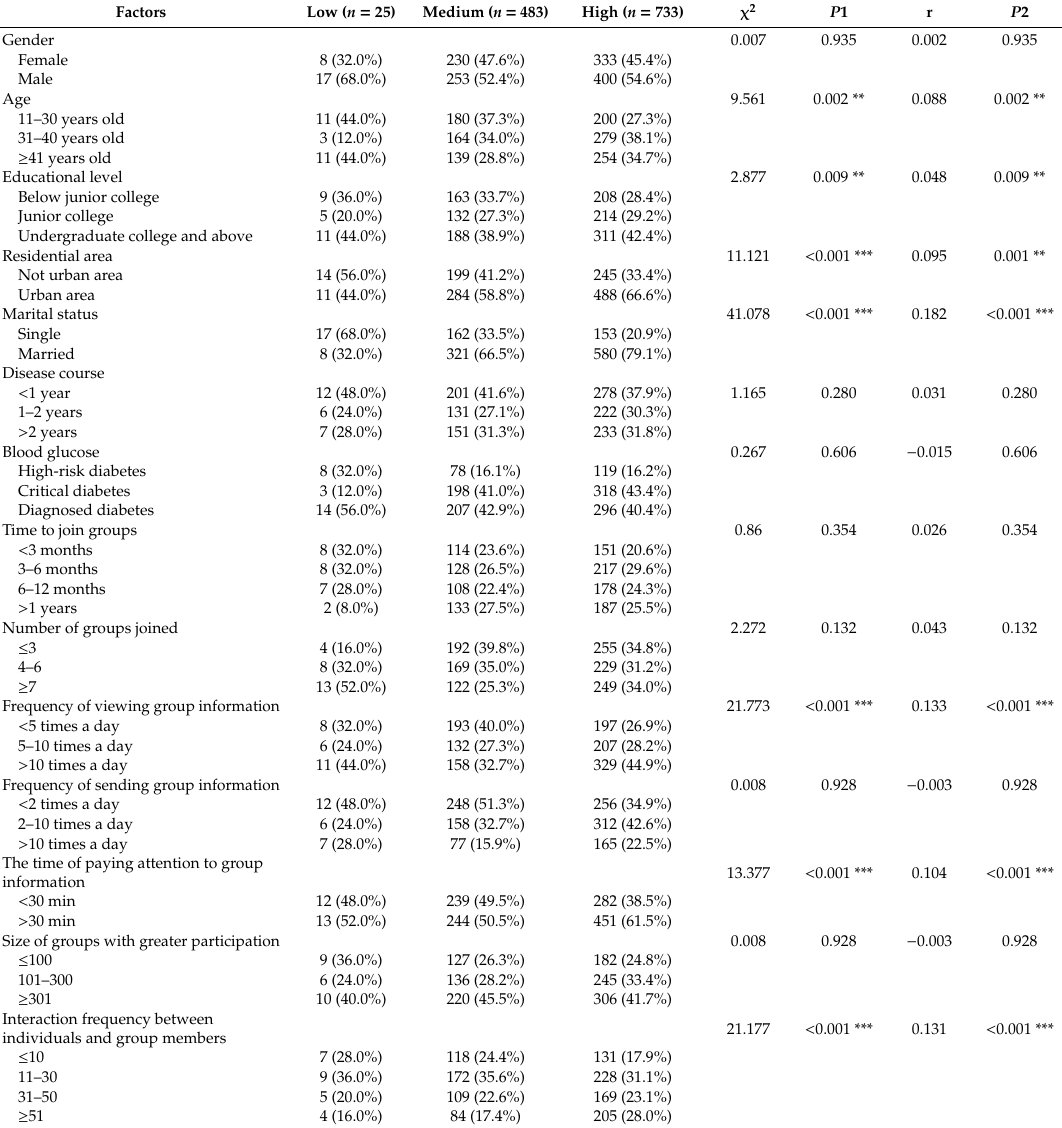
Table 3. Test for linear trend for influence factors and self-e ffi cacy of the